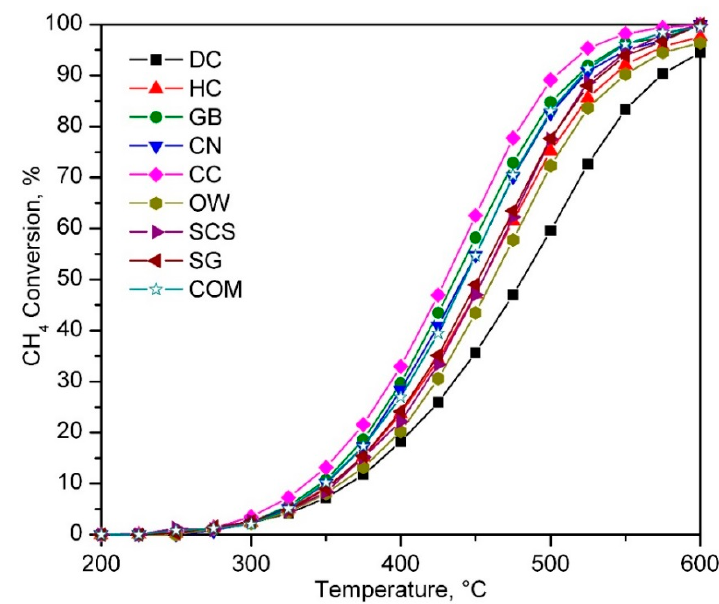
Figure 7. Light-off curves of the bulk Co 3 O 4 catalysts.